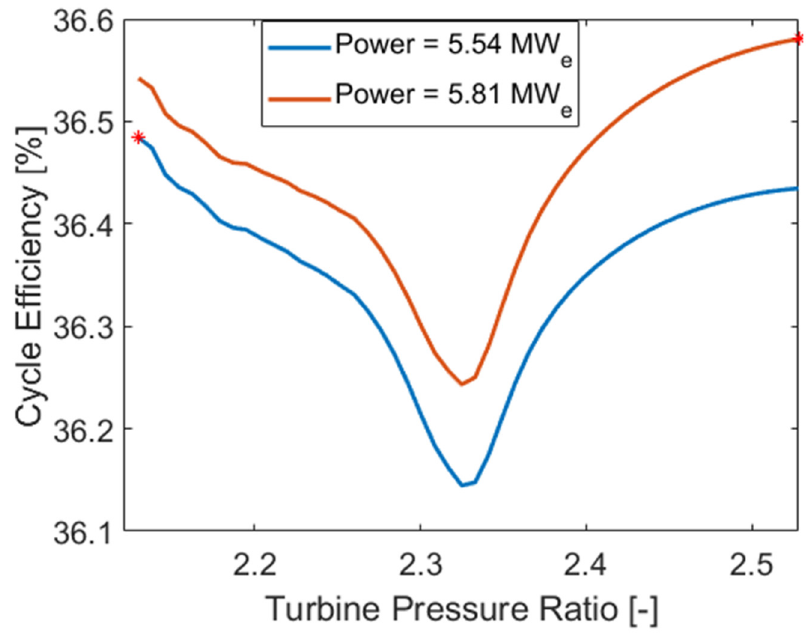
Figure 26. Optimized point at different power level.